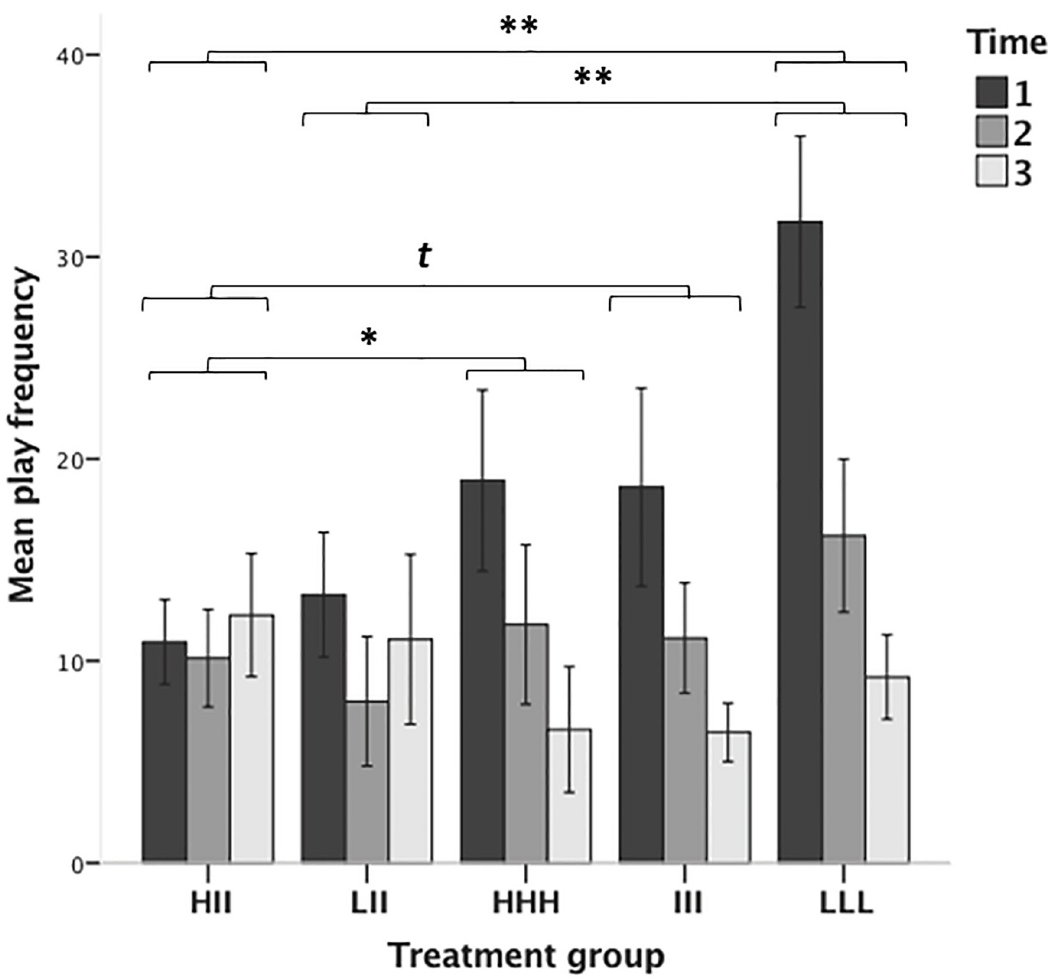
Fig 3. Histograms showing home cage play levels (pinning frequency) across treatment groups and time; given are means and S.E.M.s. Brackets indicate differences between treatment groups ( t : p < 0.1; � : p < 0.05; �� : p < 0.01). other group comparisons at Time 1, p � 0.02 (Bonferroni adjustment: α = 0.005). The treat- ment groups also did not differ at Time 2 or at Time 3 (all p � 0.10). With regard to the main effect of treatment group and based on the estimates of fixed effects (i.e., with all time points taken together), the HII group played less than the HHH ( t = 205.48 1.98, p = 0.04) and LLL ( t = 3.46, p = 0.001) groups, and also tended to play less than the 205.48 III group ( t = 1.96, p = 0.06). Similarly, the LII group played less than the LLL group 205.48 ( t = 2.96, p < 0.01), yet did not differ from the HHH ( t = 1.48, p = 0.14) and III 205.48 205.48 ( t = 1.44, p = 0.15) groups. By contrast, play levels did not differ between heterogeneous 205.48 groups (HII vs. LII: t = 0.52, p = 0.60) or between homogeneous groups (III vs. HHH: 205.48 t 205.48 = 0.03, p = 0.98; III vs. LLL: t 205.48 = 1.52, p = 0.14; HHH vs. LLL: t 205.48 = 1.48, p = 0.14).